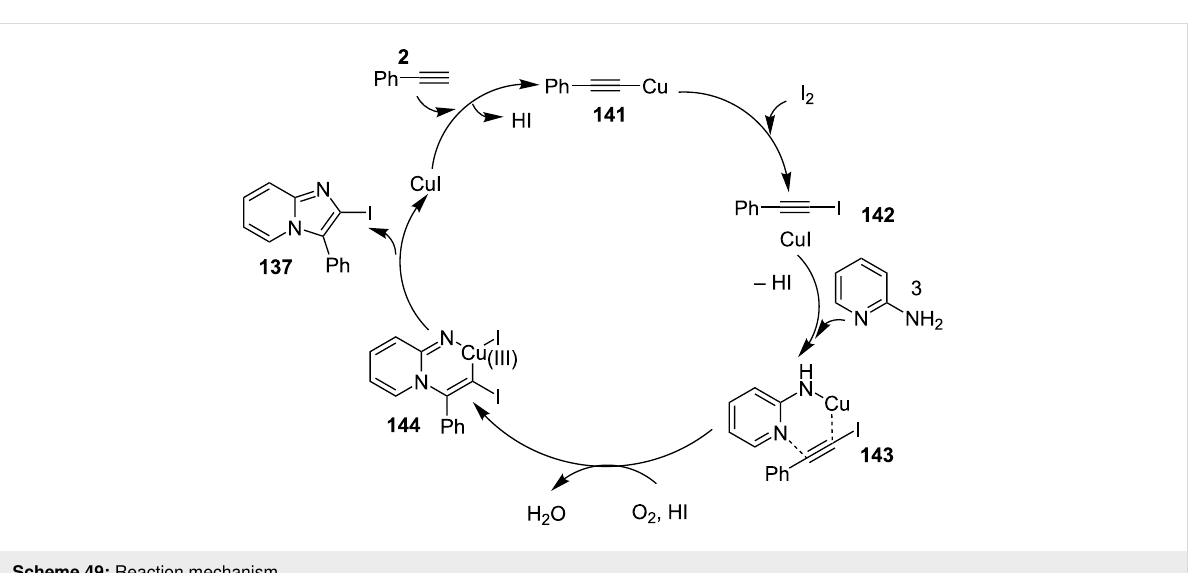
Scheme 49: Reaction